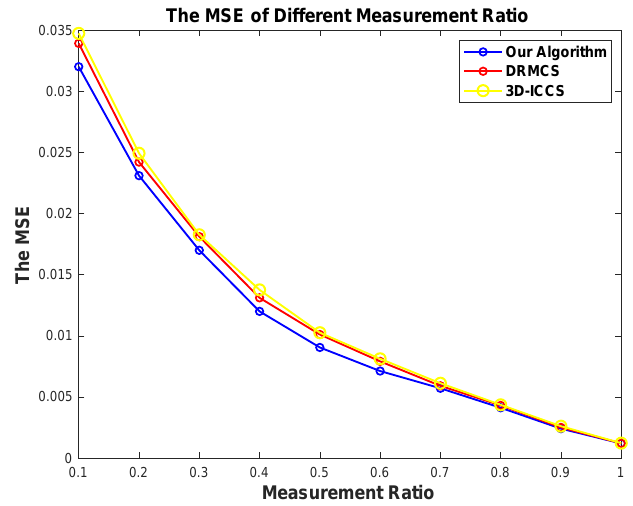
Figure 13. The comparison results in terms of MSE in different measurement